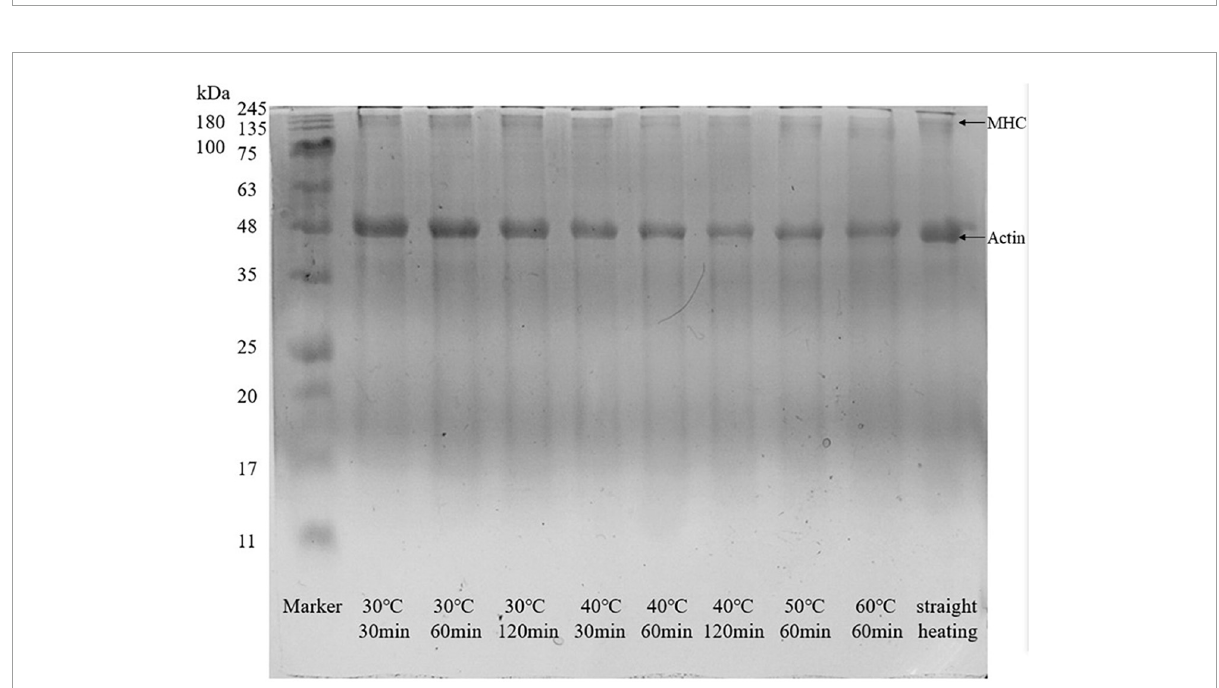
FIGURE5 SDS-PAGE of surimi gel under different heating